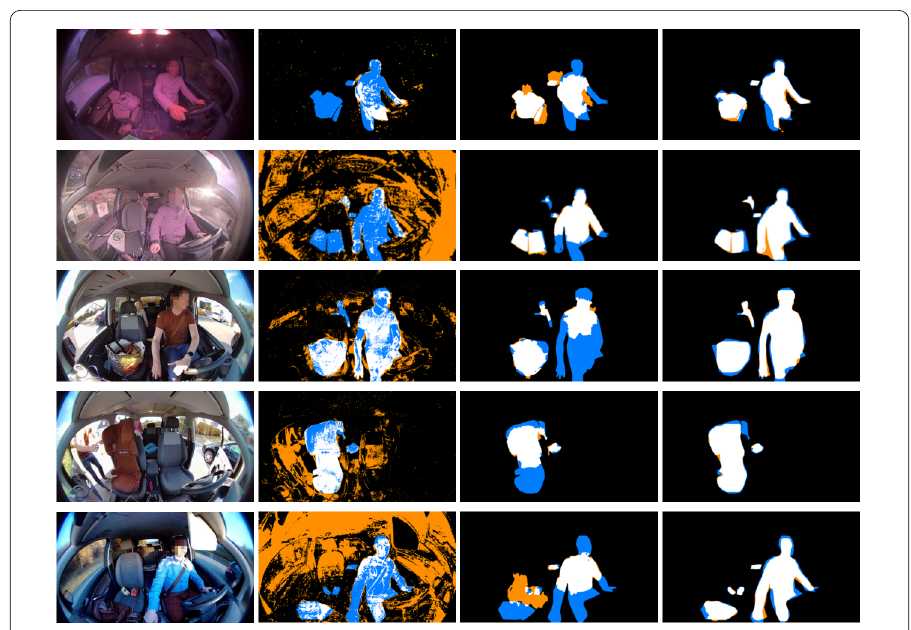
Figure 13 Comparison of the masks predicted by the investigated methods. 1st column: The RGB real-world images. 2nd column: The masks predicted by the GMM. 3rd column: The masks predicted by the Morphsnakes. 4th column: The masks predicted by the Mask